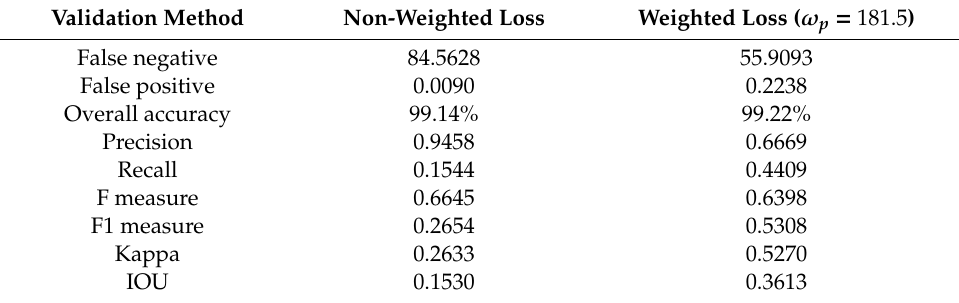
Table 3. The accuracy of non-weighted loss compared with that of weighted loss for the Bangkok testing site.